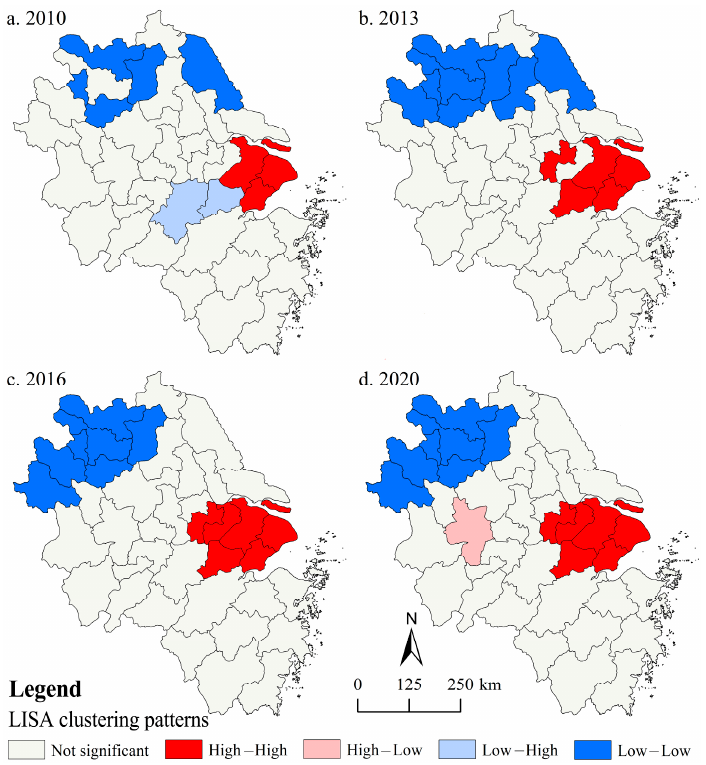
Figure 7. LISA Significance Clustering of the BPSL in the YRDR, 2010–2020.